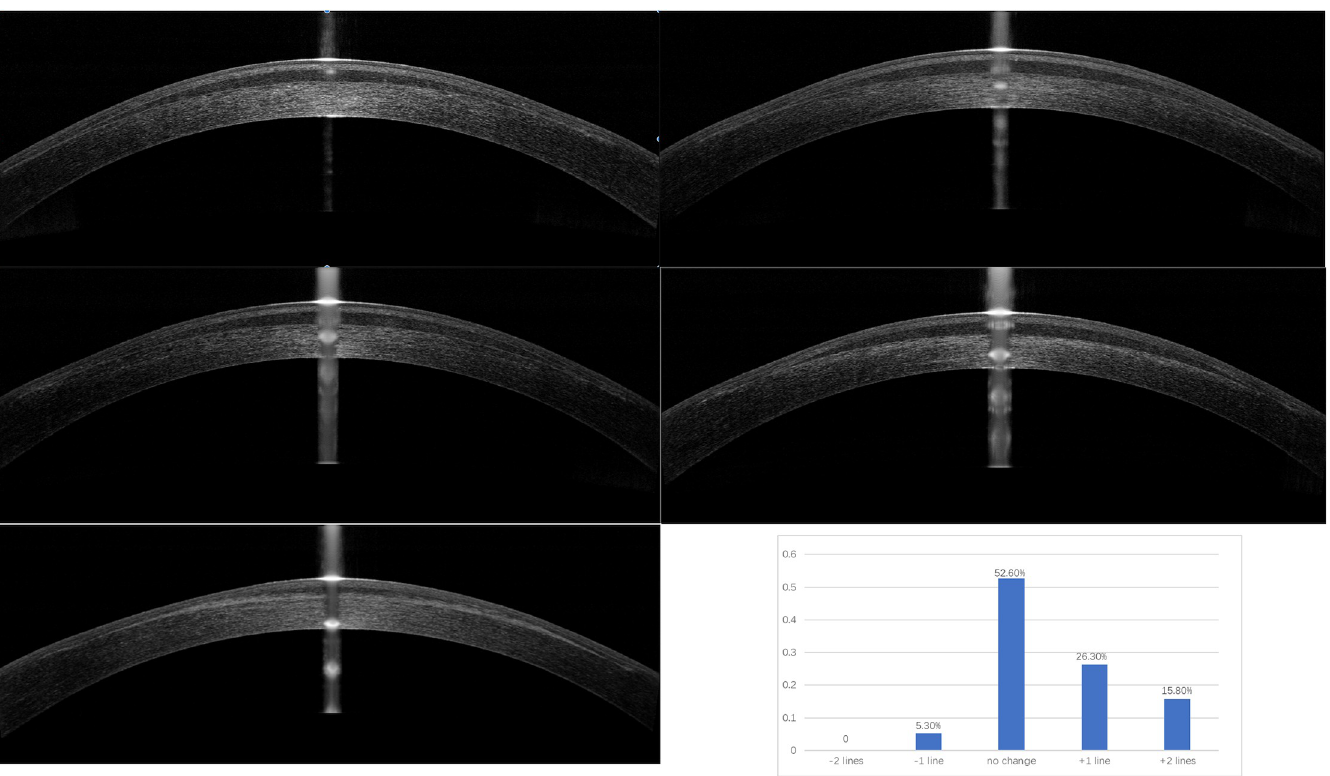
Fig 2. Anterior segment OCT images of corneas with lenticule implantation at each follow-up visit. Pictures a-e respectively represents OCT images 1 day, 1 week, 1 month, 3 months and 1 year after surgery. The implanted lenticule was in the center and shaped like a crescent in the corneal stroma, with no offset and wrinkles at each visit. The lenticule demarcation line blurred at 1 year after surgery.